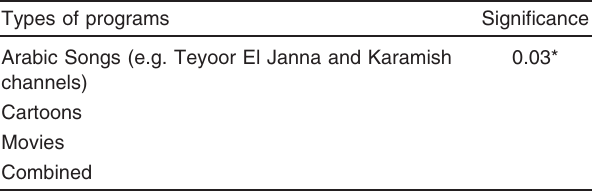
Table 5 The effect of different types of programs and inattention Types of programs